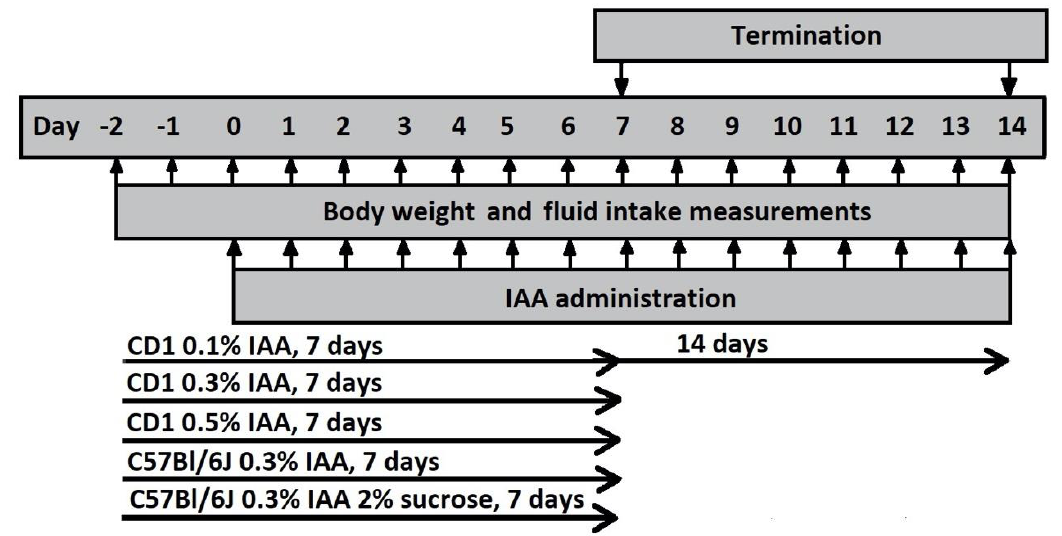
13 of 19 Figure 9. Experimental design of IAA gastritis with Wistar rats. Male Wistar rats were divided into 8 groups according to the duration of the protocol (7 days or 14 days) and concentration (0.05%, 0.1% or 0.2%) of IAA dissolved in drinking water. Control rats received tap water. Body weight and fluid intake were monitored daily throughout the experiment. At the end of the protocol, rats were euthanized and their stomachs were excised for macroscopic, microscopic evaluation and further